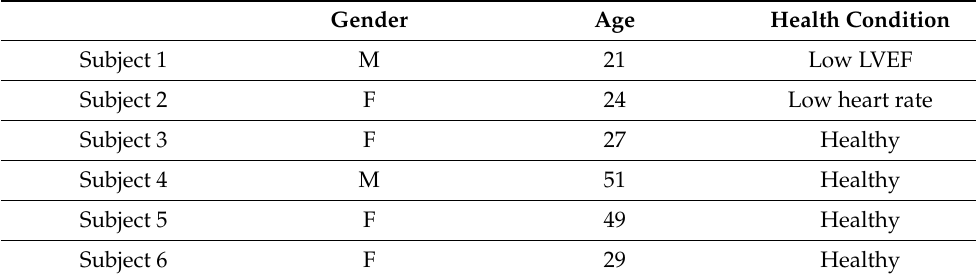
Table 1. Information for the six subjects involved in this